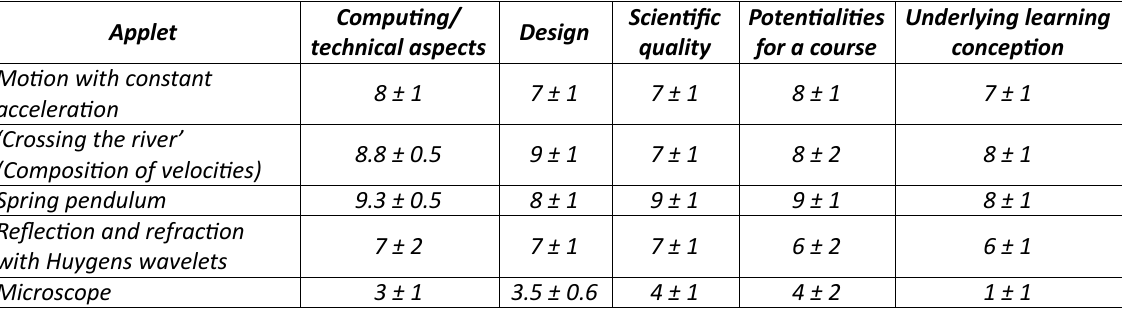
Table 3. Synopsis of the scoring of the five applets evaluated, considering the different categories (mean score ± standard deviation, out of